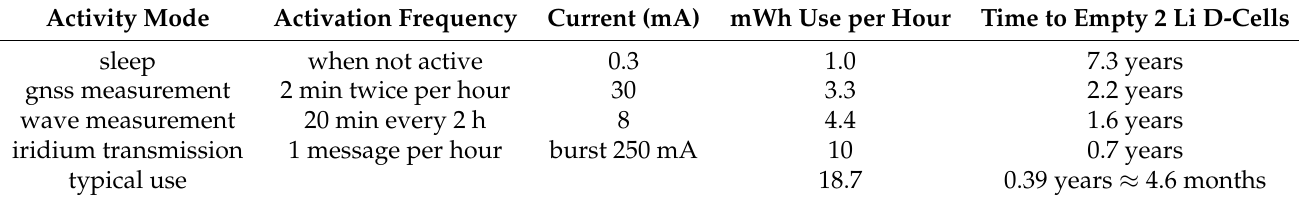
Table 1. Overview of the power consumption and resulting battery autonomy resulting from the different components of the instrument when using two nonrechargeable D-sized Lithium batter- ies. ‘Activity mode’ indicates the part of the workflow of the instrument that is being considered. ‘Activation frequency’ indicates a typical activation duration and frequency (though this is only indicative and may be modified either by using different parameters when programming the instru- ment, and/or by sending updated activity rates through the bidirectional iridium communication). ‘Current (mA)’ is the average current used in the corresponding mode when it is active. ‘mWh use per hour’ indicates the corresponding energy use for the given activation mode, following the formula mWhUse Per Hour = Current (mA) × 3.3 (V) ×